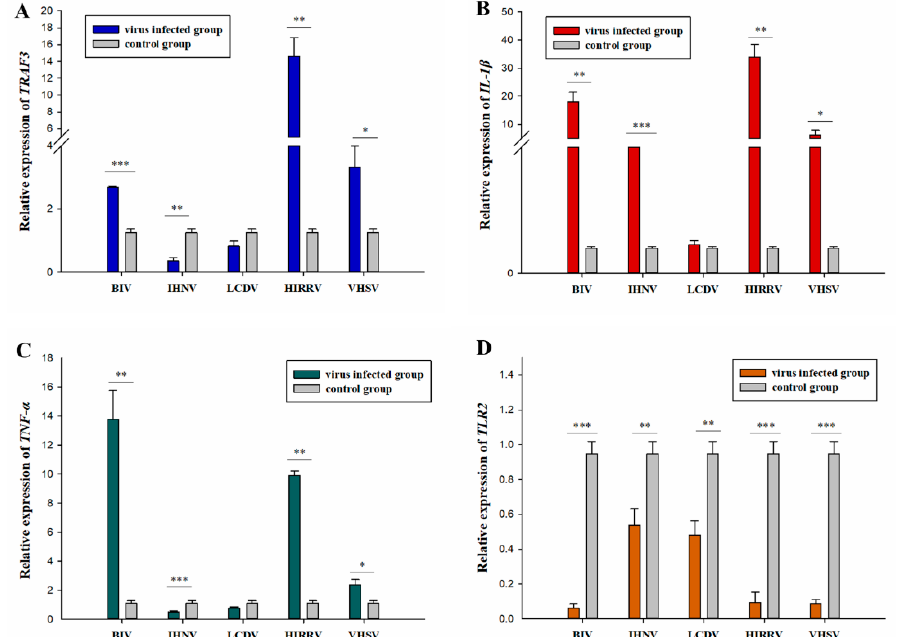
Figure 9. Expression of immune-related genes during infection of JFSP cells by BIV, VHSV, HIRRV, IHNV, or LCDV. ( A – D ) Relative expression levels of immune-related genes (TRAF3, IL-1 β , TNF- α , and TLR2) in JFSP cells infected with the five viruses for 36 h p.i. Uninfected JFSP cells were used as a control group. All data are expressed as mean ± SEM ( n = 3). * indicates a significant level of difference at p < 0.05, ** indicates a very significant level of difference at p < 0.01, and *** indicates an extremely significant level of difference at p < 0.001.